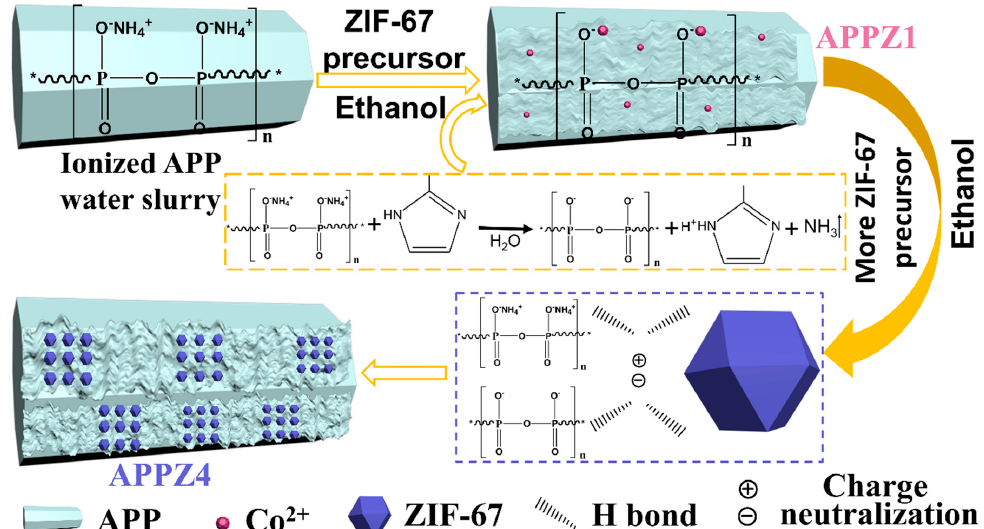
Figure 1. Illustration of the interface assembly mechanism of ammonium polyphosphate zeolite imidazole frameworks (APP-ZIFs).